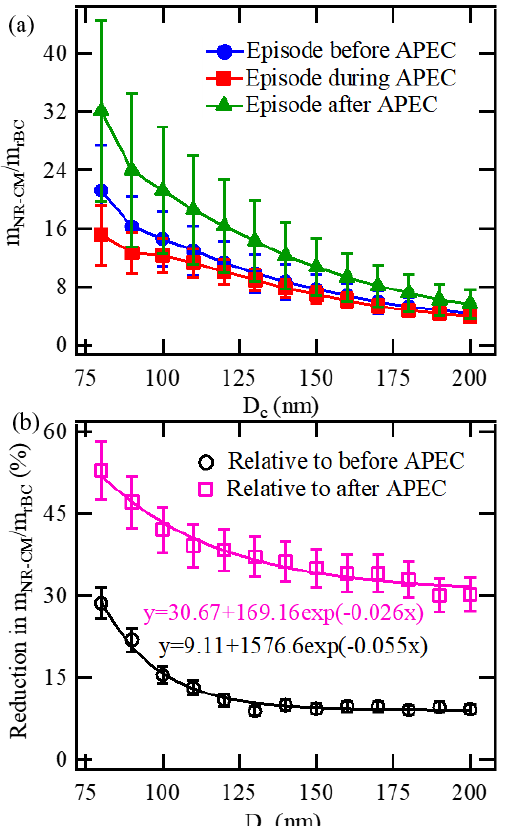
Figure 3. Comparison of the aging degree of BC-containing par- ticles for the pollution episodes before, during and after APEC: (a) the m NR − CM /m rBC ratio of BC-containing particles and (b) the reduction in the m NR − CM /m rBC ratio of BC-containing particles during APEC relative to those before and after APEC.